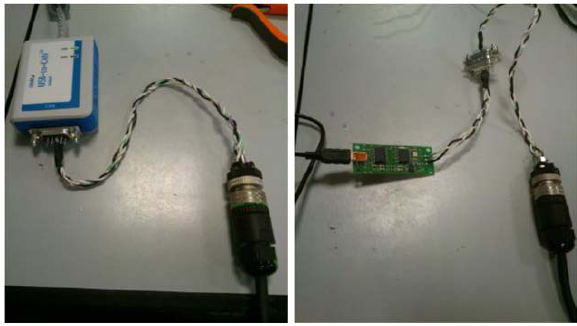
Figure 8. ( left ) IXXAT USB to CAN, ( right ) open-source Serial to